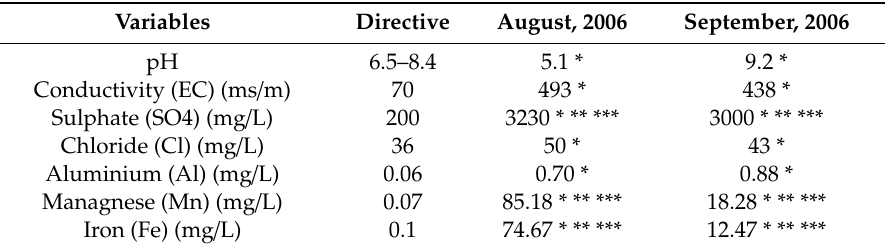
Figure 3. Tweelopiespruit (TLS) flowing out of Aviary Dam, Krugersdorp Game Reserve (KGR, 3 Feb 2011). Source: [27]. Table 1. Hydrochemical parameters of water from the KGR inlet (i.e., “treated water”) for August and September 2006 in relation to the Department of water A ff airs and Forestry (DWAF) Directive requirements. Source: Du Toit, 2006